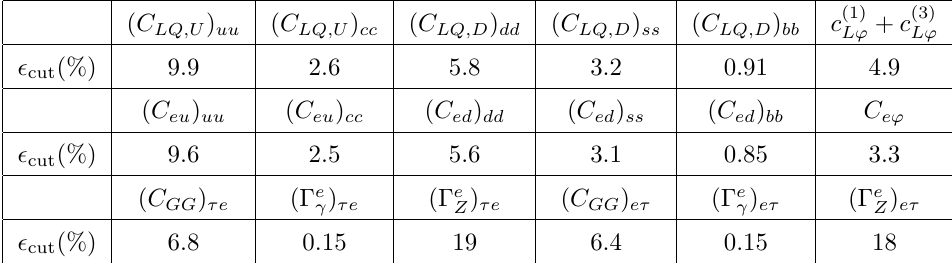
Table 6 . Cut efficiency in the muonic channel, in units of 10 − 2 , for various SMEFT operators at √ the EIC with energy E = 20 GeV and E = 250 GeV ( S = 141 GeV). There is no background e p after including the kinematic